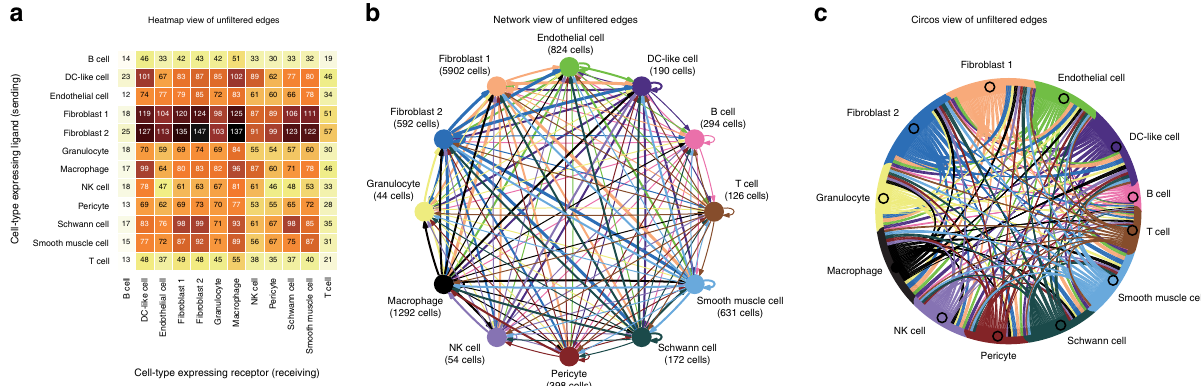
Fig. 2 Cell-connectivity-summary-network visualisations in NATMI. To identify cell types that are communicating ‘ more ’ than others in Skelly et al. 11 , the number of ligand – receptor pairs (detected in more than 20% of cells) connecting each pair of cell types were counted. Resulting simple edge-count-based cell-connectivity-summary network is shown using three distinct visualisation methods available in NATMI. a Heatmap view. Rows indicate cells expressing the ligands and columns indicate cells expressing the receptors. Number of ligand – receptor pairs connecting the cell – cell pairs are indicated and coloured relative to max count. b Network-graph view and c Circos-view for the same network. For b , c , edges are coloured by ligand expressing cell type, arrows indicate target cell type and thickness is proportional to the number of ligand – receptor pairs connecting the two cell types. The NATMI directed heatmap visualisation is asymmetric. This recognises that cell communication is directional and that although one cell type may send many signals to another there is no guarantee that it